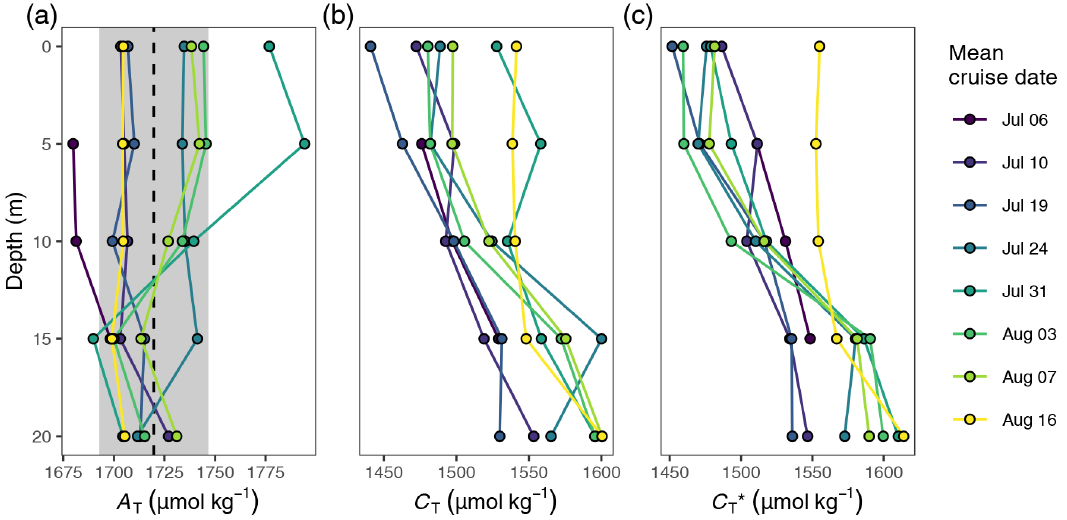
Figure B1. Vertical profiles of (a) A T , (b) C T , and (c) C T normalised to the mean alkalinity ( C ∗ samples taken at stations 07 and 10. The dashed line and grey area in (a) indicate the mean ± 1 standard deviation of A T across the upper 20m of the water